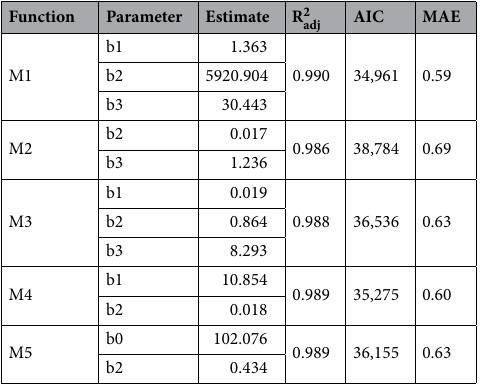
Table 5. Parameter estimates and goodness-of-fit statistics for the individual functions. R 2 adj adjusted coefficient of determination, AIC akaike information criterion, MAE mean absolute error.